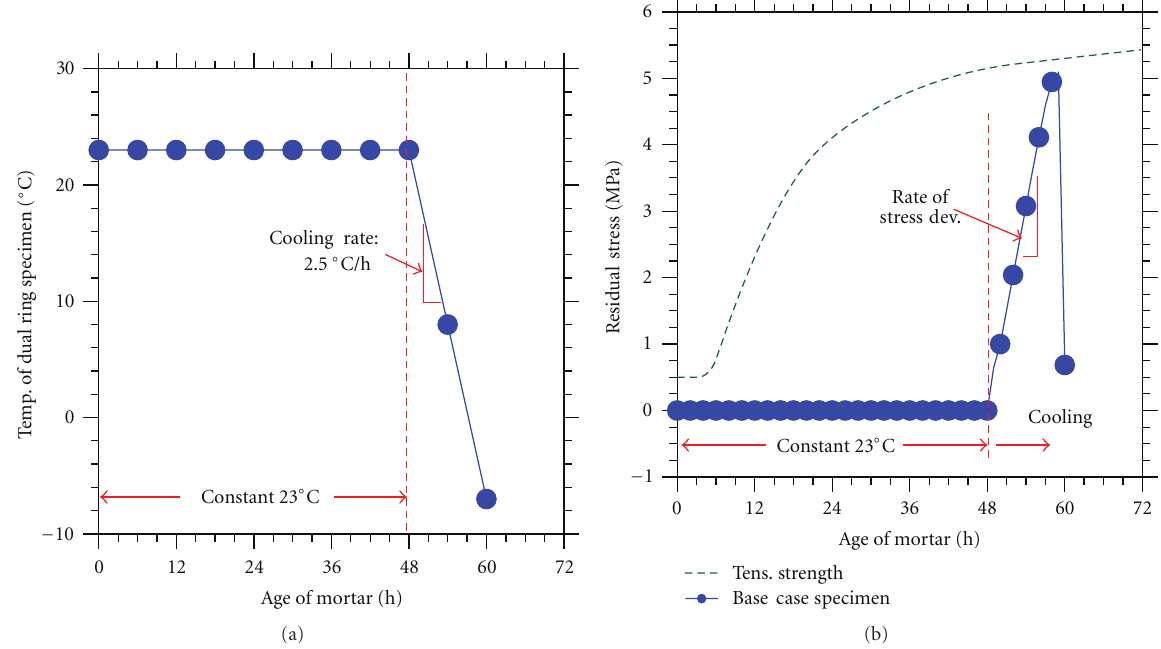
Figure 5: (a) Temperature profile and (b) average residual stress development in base case specimen when cooled at